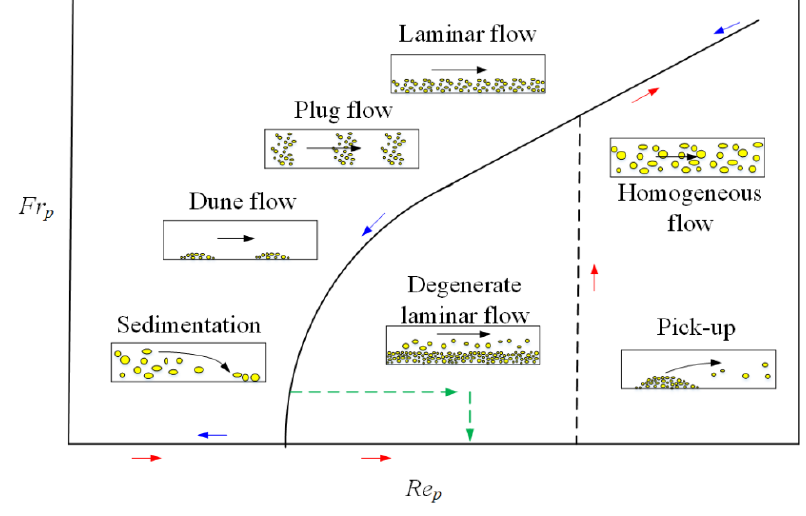
Figure 1. Model of flow regimes observed for horizontal pneumatic conveying.